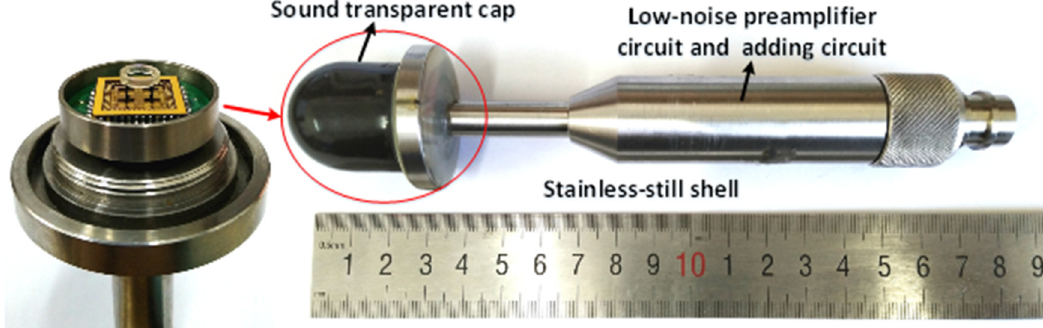
Fig. 17. Material object of hydrophone.